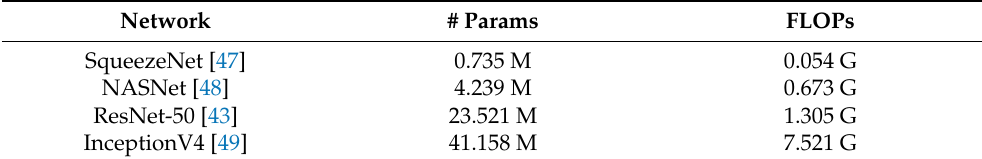
Table 3. Networks trained on CIFAR-10 and their parameter quantities as well as calculation overhead. Network # Params FLOPs